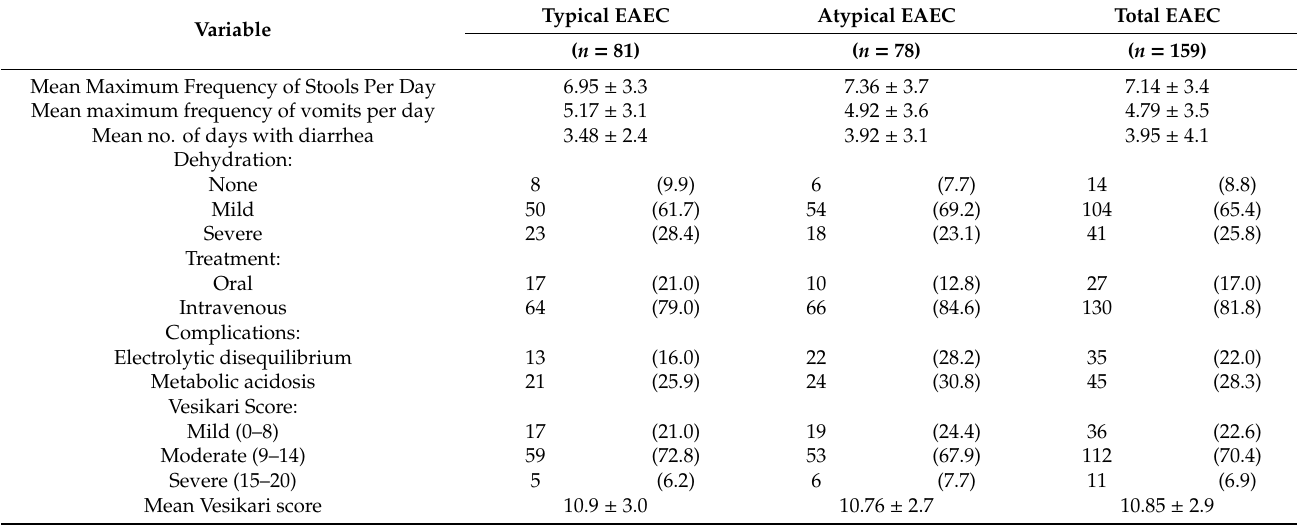
Table 2. Clinal symptoms and severity scores of pediatric subjects with diarrhea caused by t-EAEC or a-EAEC among Bolivian children. Numbers are mean +/ - SD or n (%).